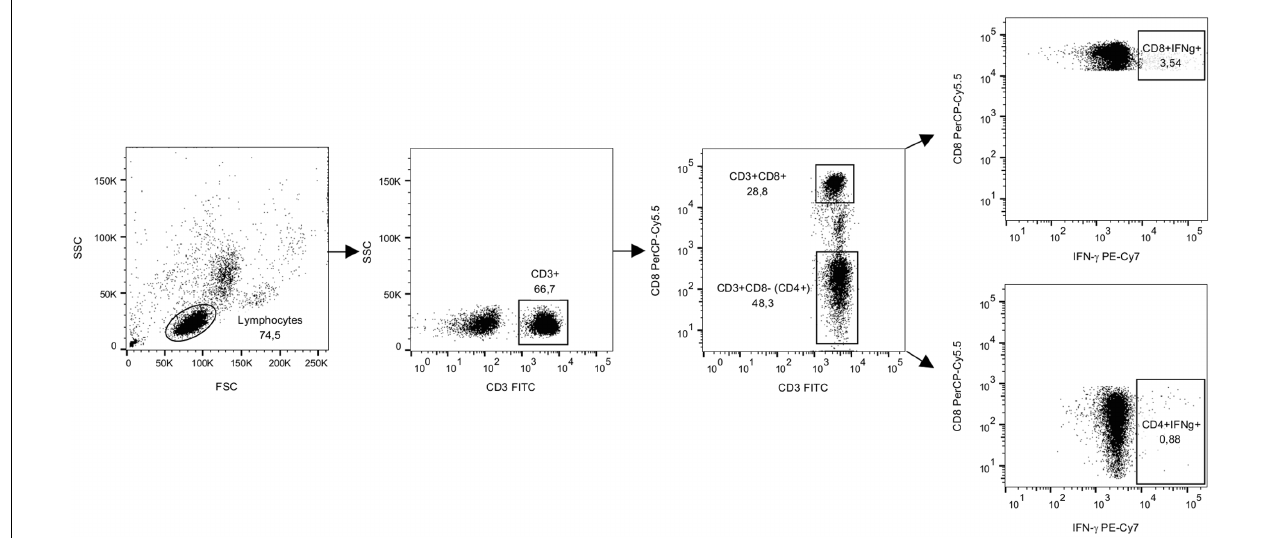
FIGURE 2 | The gating strategy for flow cytometry analysis from representative data. PBMCs from a donor were stimulated with SEB for 16 h in the presence of brefeldin A and then stained for IFN- γ and lineage markers CD3 and CD8. A forward and side scatter was used for gating the lymphocyte population. CD3 + lymphocyte population was further gated to CD8 + and CD8 − populations and IFN- γ staining was analyzed for both populations as previously described by others (Meddows-Taylor et al., 2007). Dot plots show gated populations and events as percentages of the parent